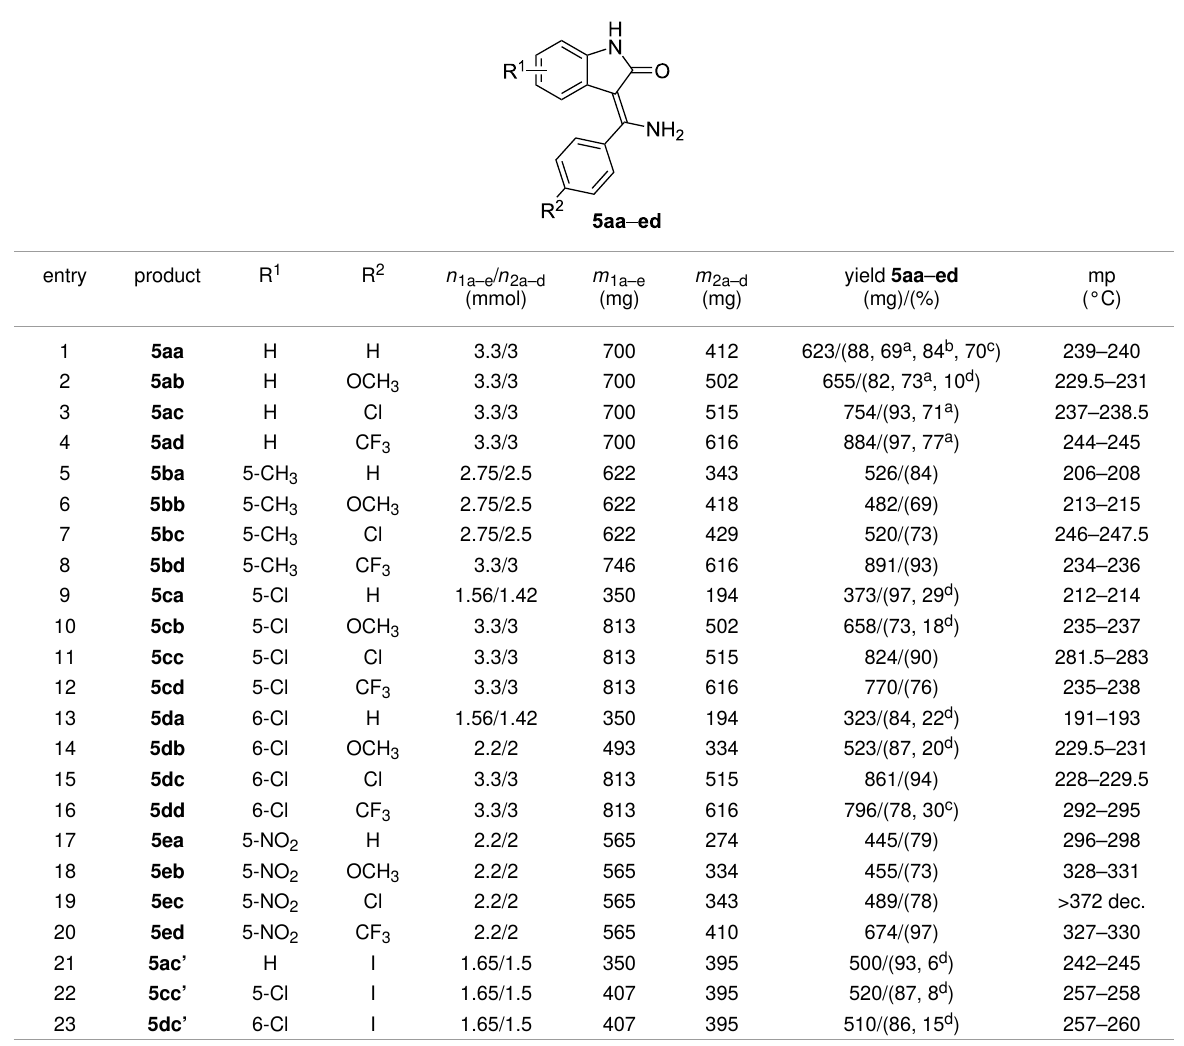
Table 2: The prepared 3-[amino(phenyl)methylidene]-1,3-dihydro-2 H -indol-2-ones 5aa–ed with a primary amino group (R 3 and R 4 :